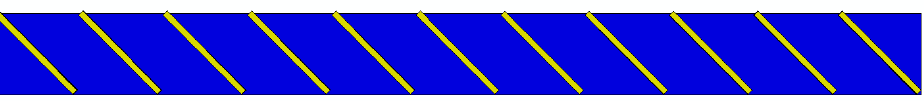
Figure 15. Configuration of the rectangular paper sheet with patterned oblique beams.